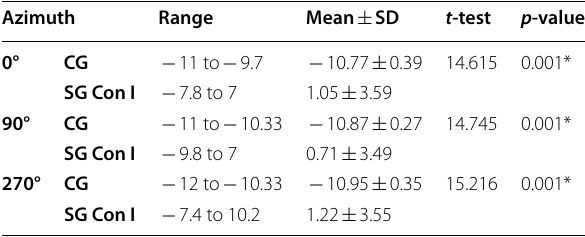
Table 2 Comparison of RTS between CG and SG in condition I